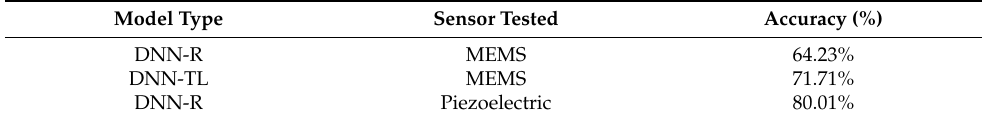
Table 3. A comparison between regular DNN model and our transfer-learning DNN model on MEMS sensors. The transfer-learning model gives an absolute gain of 7.48% over regulard DNN model.